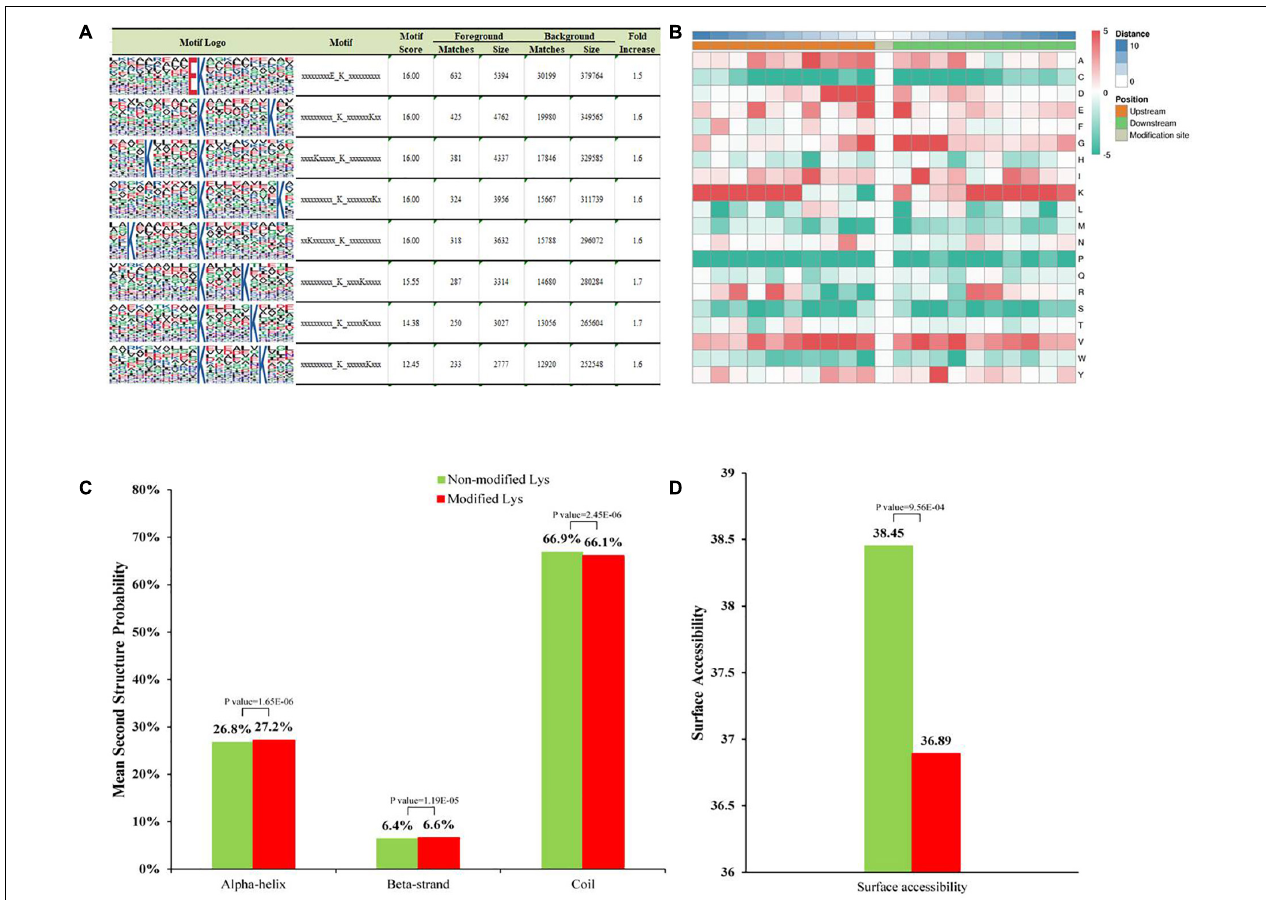
FIGURE 1 | Properties of Khib peptides in A. niger . (A) Motif analysis shows Khib peptide motifs and conservation of Khib sites. The intensity map shows enrichment of amino acids in particular positions around the Khib lysine residues. (B) Heat map of the amino acid compositions around the Khib sites. Red indicates enrichment and green indicates depletion. (C) Probabilities of Khib in different protein secondary structures (alpha helix, beta-strand, and coil structures). (D) Predicted surface accessibility of Khib